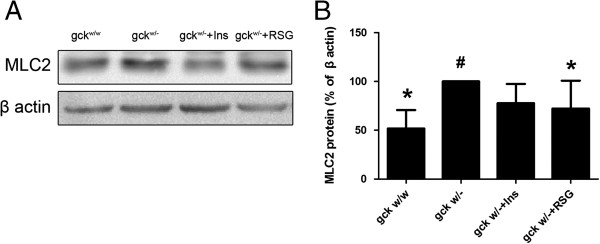
Quantification of the protein levels of myosin light chain 2 (MLC2) in 60-week old liver-specific gck knockout mice. Representative Western blot images (A) and quantification of the MLC2 Western blots in heart homogenates (B) are shown for wild-type (gckw/w) and gck knockout (gckw/–) mice as well as knockout mice treated with insulin or rosiglitazone for 4 weeks. n = 3 for all samples. Asterisk (*) refers to statistical significance (P < 0.05) in comparisons with gckw/– mice, while # refers to comparisons with gckw/w mice.